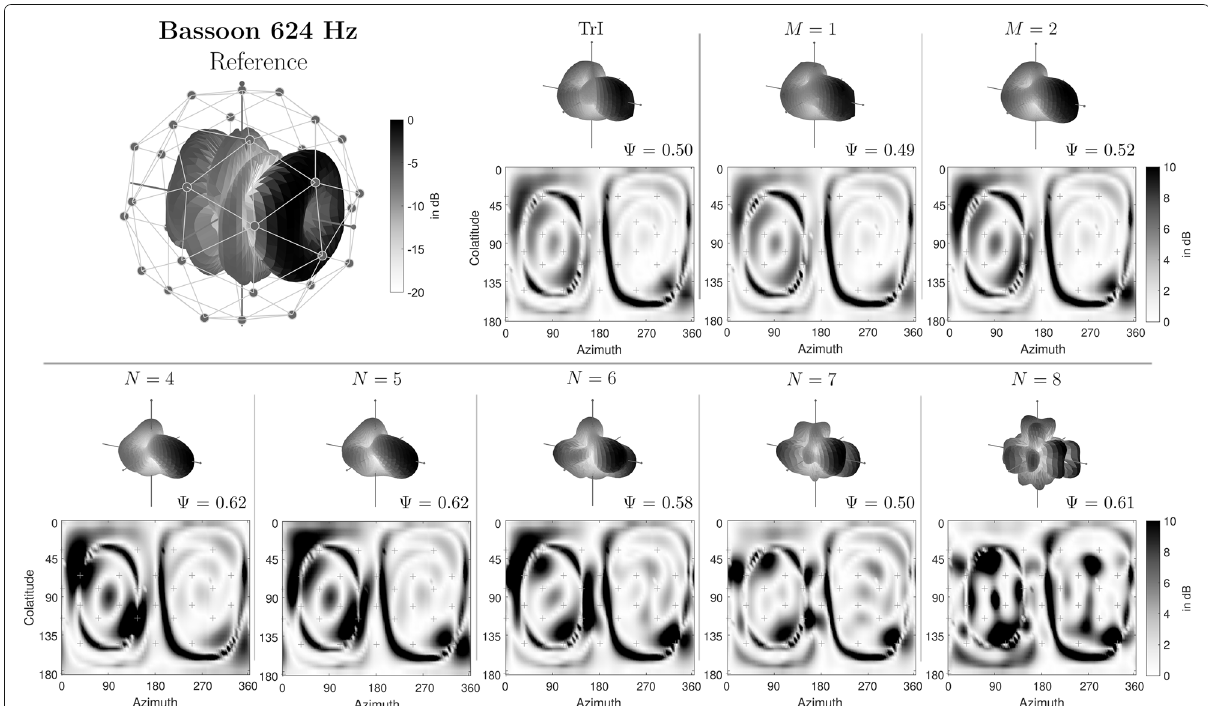
Fig. 4 The high-resolution reference of the bassoon directivety for the third overtone at f 3 = 624 Hz is shown with the 32 sampling points in the upper left. The triangular interpolation (TrI) and spline interpolation estimate for M = { 1,2 } is shown at the top and the results of the spherical harmonics Interpolation (SH) for N = { 4,5,...,8 } at the bottom. The difference of sound pressure level in dB between reference and interpolation is shown over azimuth and colatitude, the gray crosses indicate the sampling points. The result for the spline interpolation with M = 3 is not included in this figure, but is shown in Fig. 6